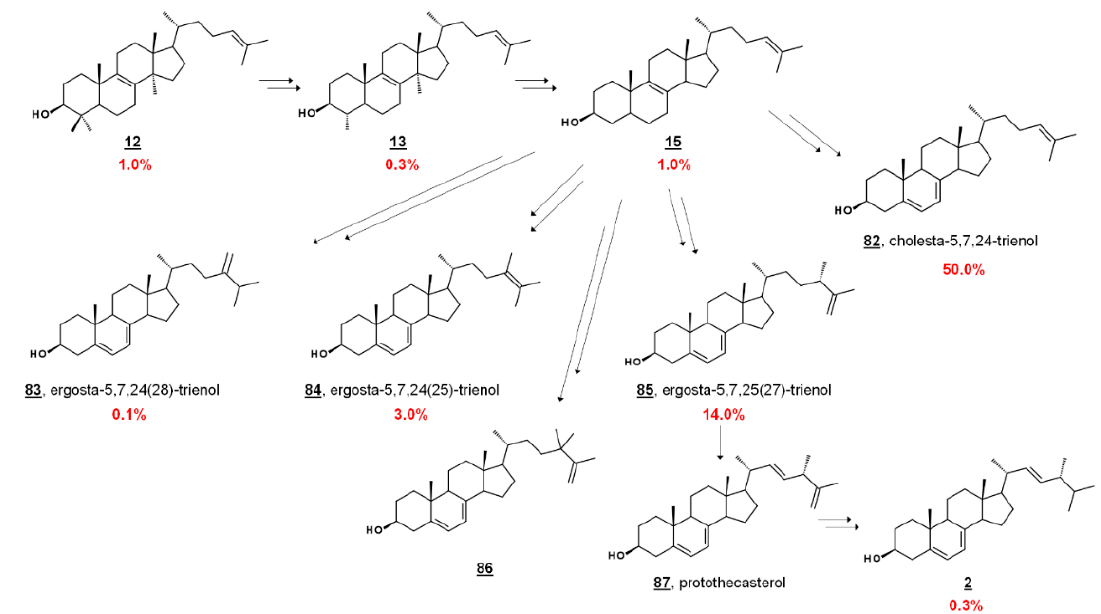
Figure 7. Abbreviated biosynthetic sterol pathway and composition in T. brucei . In T. brucei , C4 is demethylated before C14, contrary to mammalian and fungal pathways (cf. Figure 2). Values are percentage sterol composition reported by Zhou et al. [43]. Dietary cholesterol 1 accounted for 20.0%, and other components were 16 (0.1%), 30 (1.0%), 48 (1.0%), 57 (8.0%), and others (0.2%). 24,24-Dimethylcholesta-5,7,25(27)-trienol and 86 and protothecasterol 87 were not detected in this composition, but have been reported in subsequent studies [42,66], respectively.